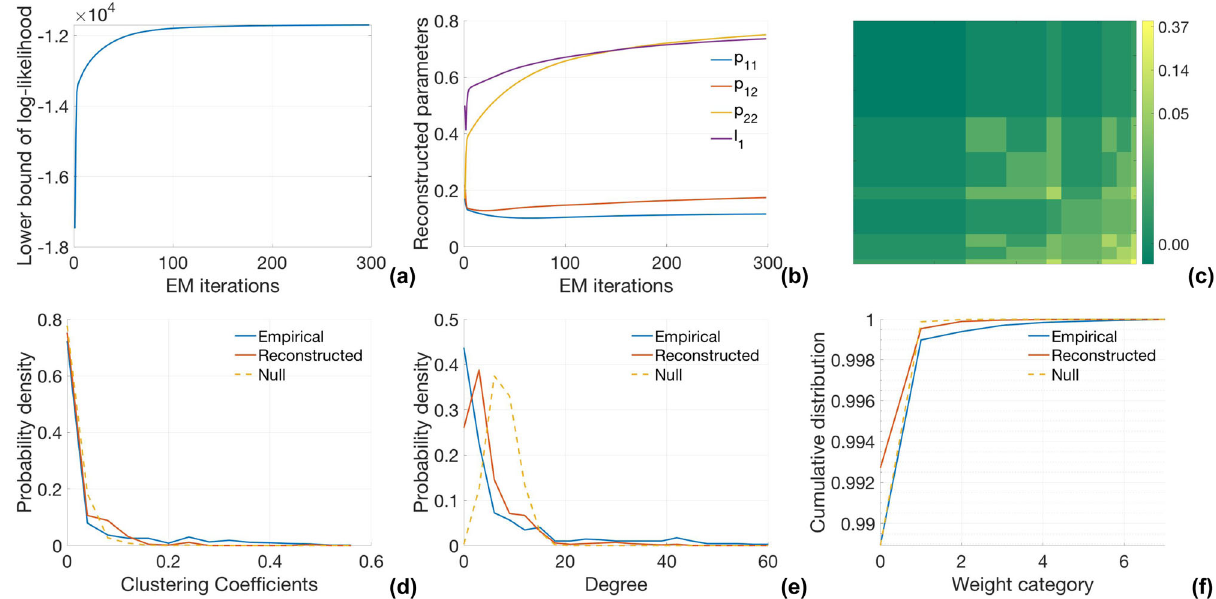
Fig. 6 Network generator reconstruction for a brain connectome. a Convergence of lower bound of log-likelihood in the weighted multifractal graph model (WMGM) estimation with expectation maximization (EM) iteration. b Convergence of WMGM parameters. c Reconstructed network generator model θ K visualized as a square. Here the model construction iteration is K = 3. The values of node attribute probability l K are presented as the side lengths of sub-block. Linking probability p K are visualized as the sub-block colors. The value can be read with the colorbar on the right. Empirical clustering coef fi cient d , degree distribution e and cumulative weight distribution f the in brain connectome (empirical), a synthetic network generated by the reconstructed network generator model (reconstructed), and a network generated by the Erdos-Renyi mode (null).